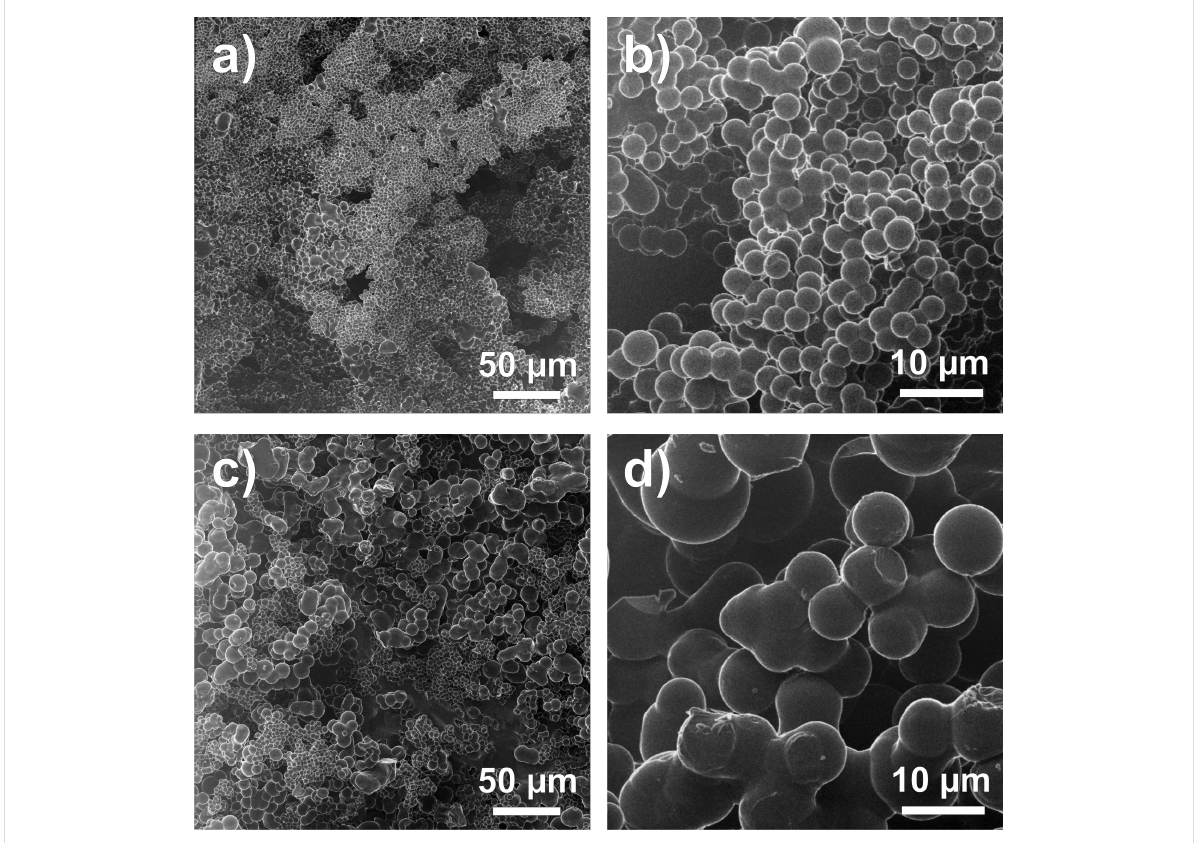
Figure 1: Helium-ion microscopy (HIM) images of low-density (a,b) and high-density (c,d) carbon nanofoams, with different